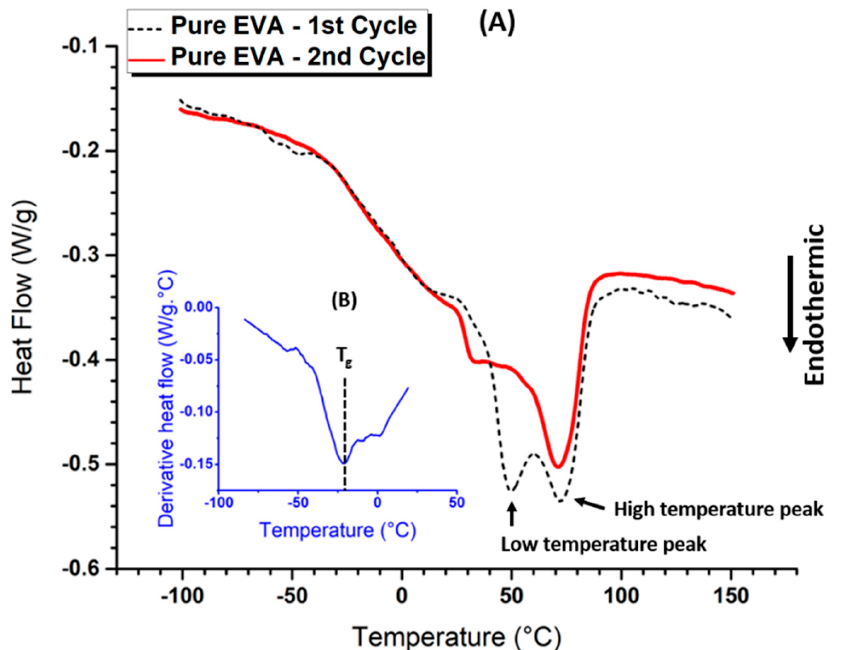
Figure 2. ( A ) DSC analysis of pure EVA-2 thermal cycles detailed in Figure 16, ( B ) the normalized heat flow derivative as a function of temperature.